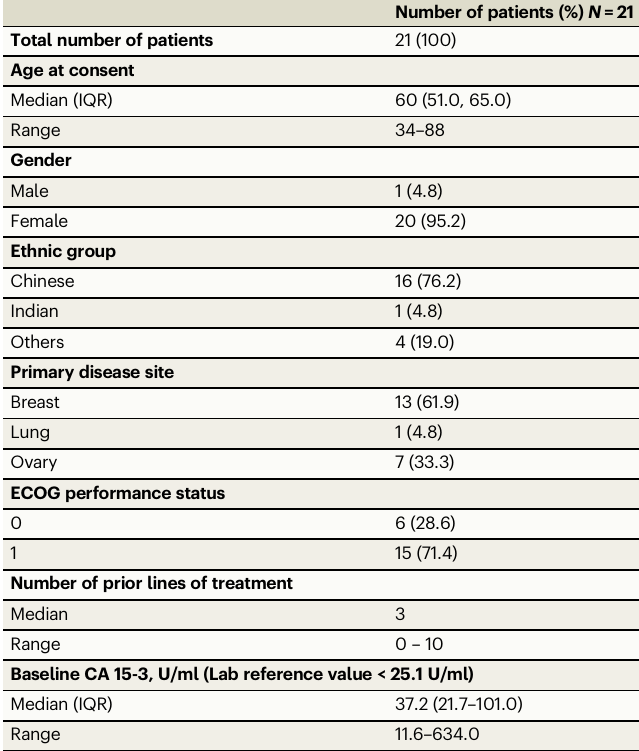
Table 1 | Patient demographics and clinical